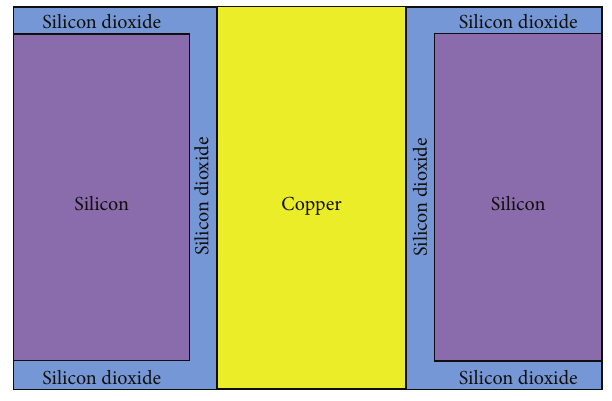
Figure 1: TSV structure.